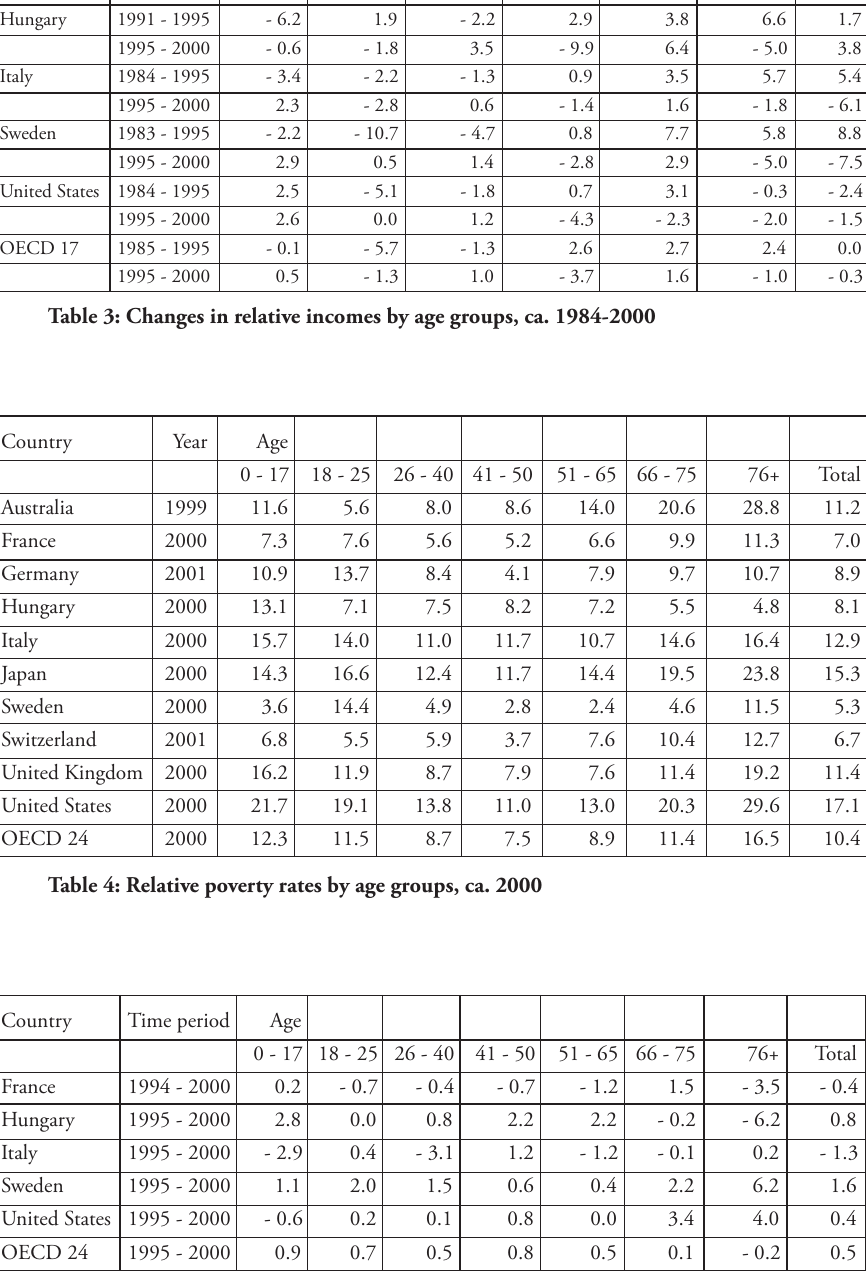
Table 5: Changes in relative poverty rates by age groups, ca.